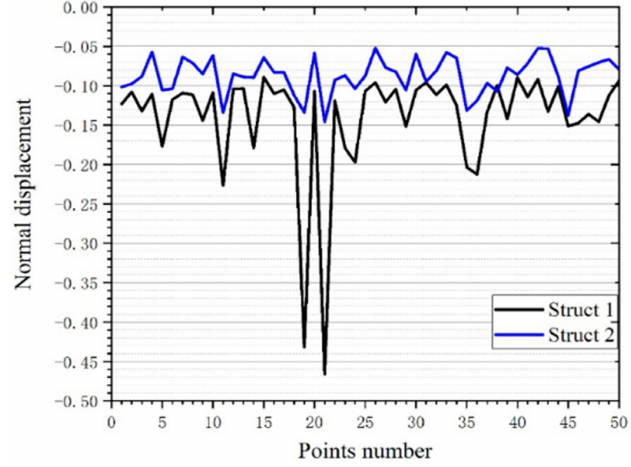
Figure 30. Comparison of the normal displacement of the force point of structure 1 and structure 2.